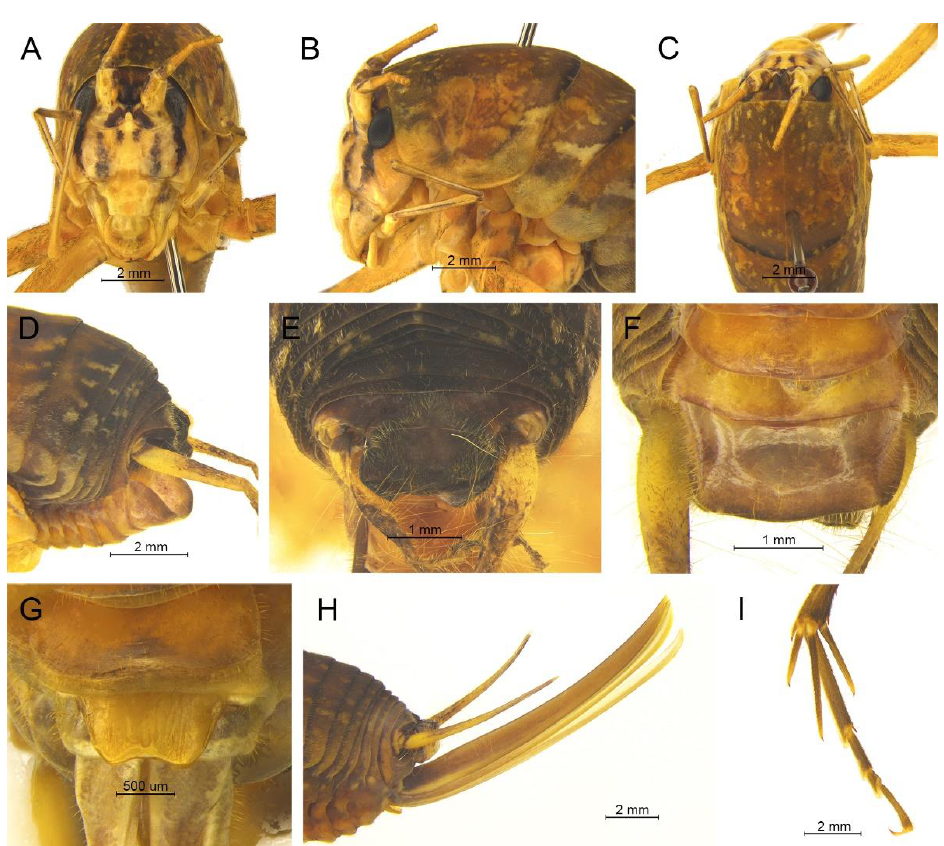
Figure 24. Homotachycines fusus Zhu & Shi sp. nov., male: ( A – C ) head and pronotum: ( A ) frontal view, ( B ) lateral view, ( C ) dorsal view; ( D – F ) apex of abdomen: ( D ) lateral view, ( E ) dorsal view, ( F ) ventral view; ( I ) hind tarsus in lateral view; female (nymph): ( G ) subgenital plate in ventral view; ( H ) ovipositor in lateral